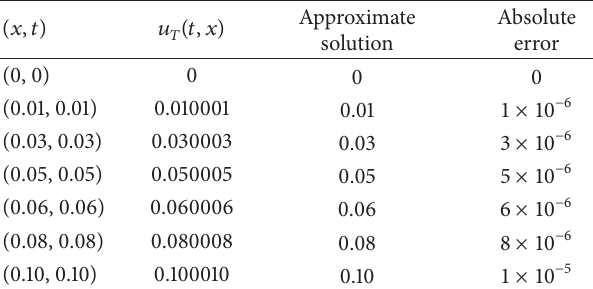
Table 2: Comparison of the absolute error 𝜀 = 1 × 10 −4